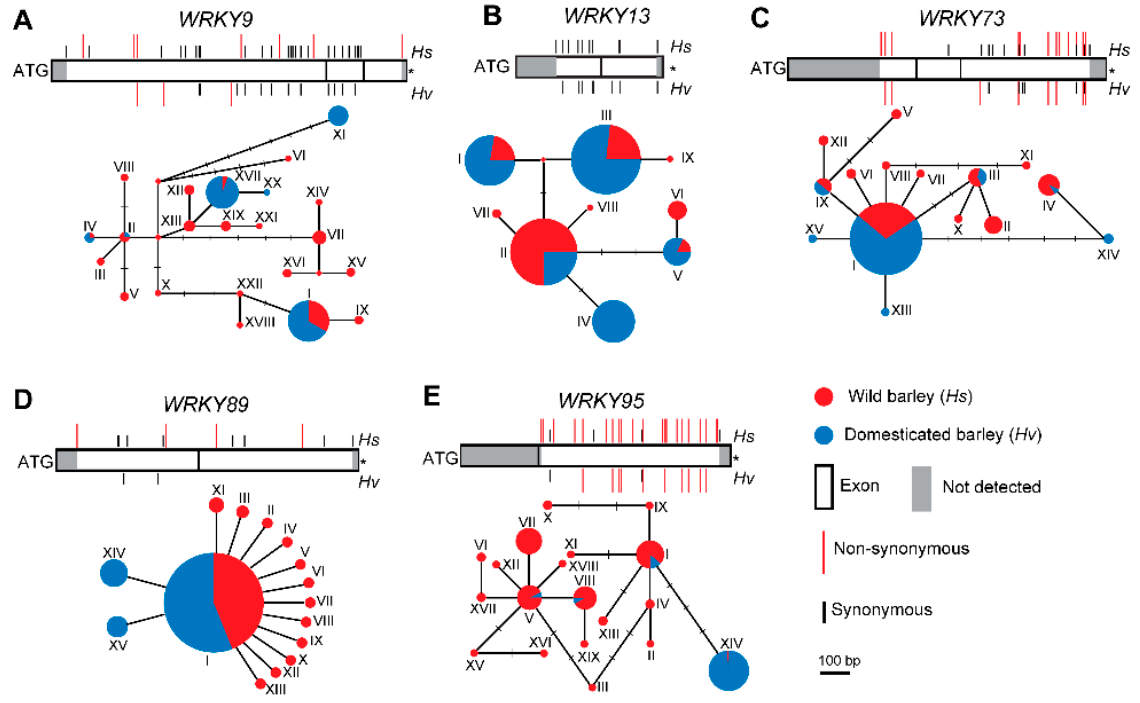
Figure 3. Haplotype analysis of nine WRKYs in wild and cultivated barley population. The nucleotide substitutions in the coding region and the haplotype network of WRKY9 ( A ), WRKY13 ( B ), WRKY73 ( C ) , WRKY89 ( D ) and WRKY95 ( E ). The rectangles represent the coding region of each gene, while the grey box indicates the part without qualified sequences. The size of each circle briefly refers to the number of the accessions containing a particular haplotype. Each short solid line represents a single mutation among haplotypes. The red and black lines indicate the positions of non-synonymous and synonymous mutations in the coding sequence, respectively. * Stop codon removed, Hs , Hordeum vulgare ssp. spontaneum ; Hv , Hordeum vulgare ssp. vulgare .